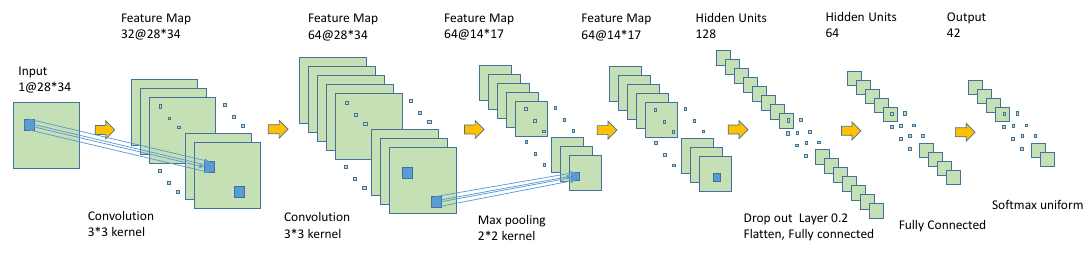
Figure 6. The architecture of a character recognition